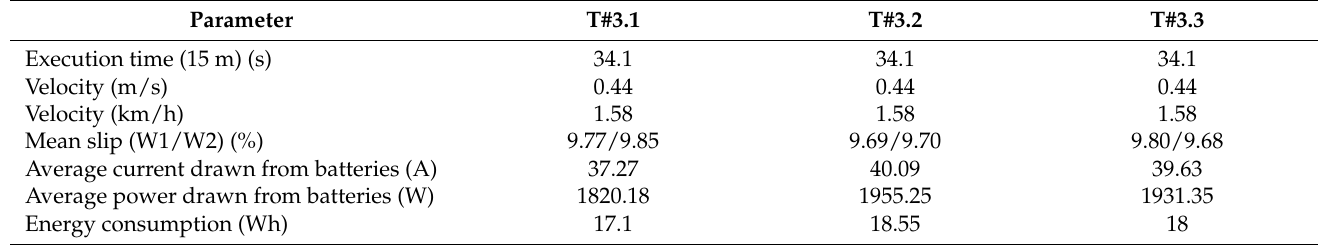
Figure 30. Energy consumption during the trial sessions carried out on firm soil with the slip auto- matically adjusted by the proposed control scheme. Table 3. Summary of parameters measured during the trial sessions carried out on firm soil with the slip automatically adjusted by the proposed control scheme.